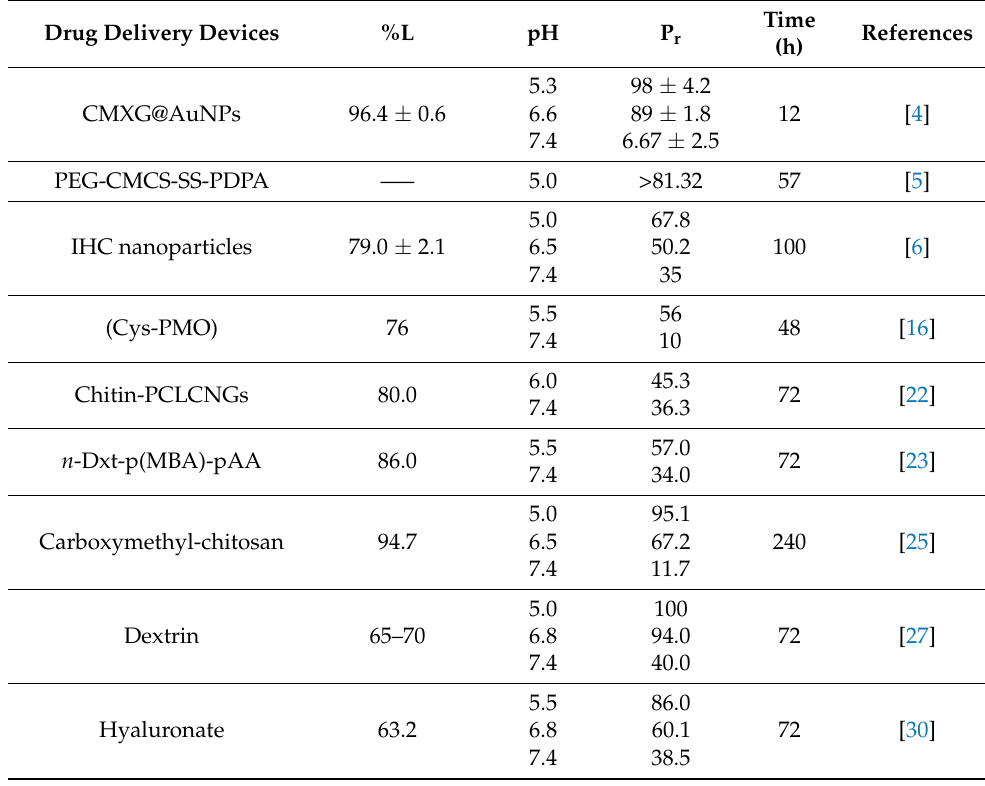
Table 3. Comparison of the loading efficiency (%L) and %release (P r ) of DOX for various drug delivery devices with the synthesized